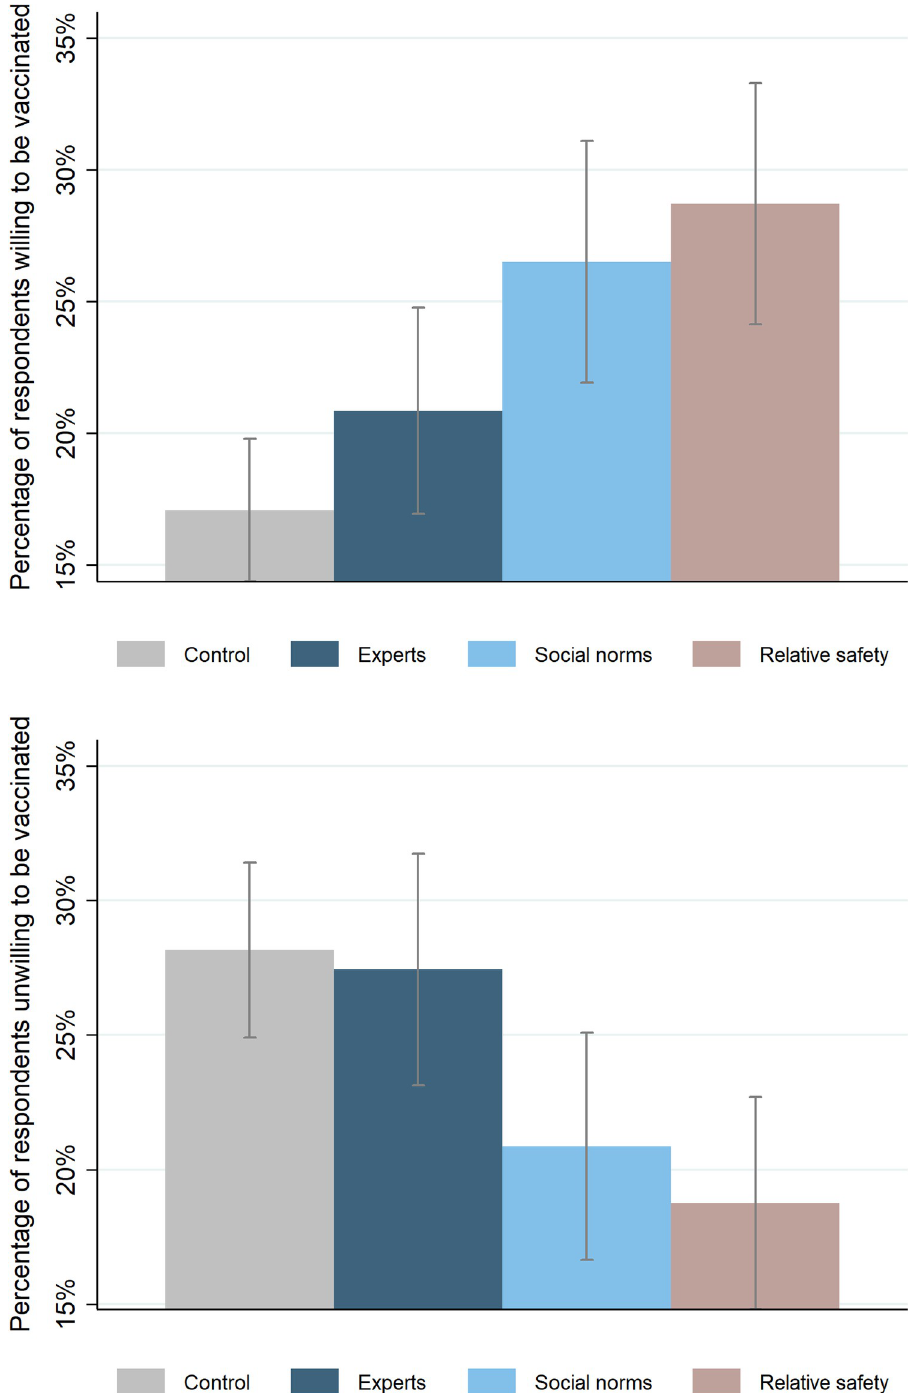
Fig 5. Treatment effects on people’s willingness and unwillingness to get vaccinated. Notes: 95 percent confidence intervals are shown in error bars.